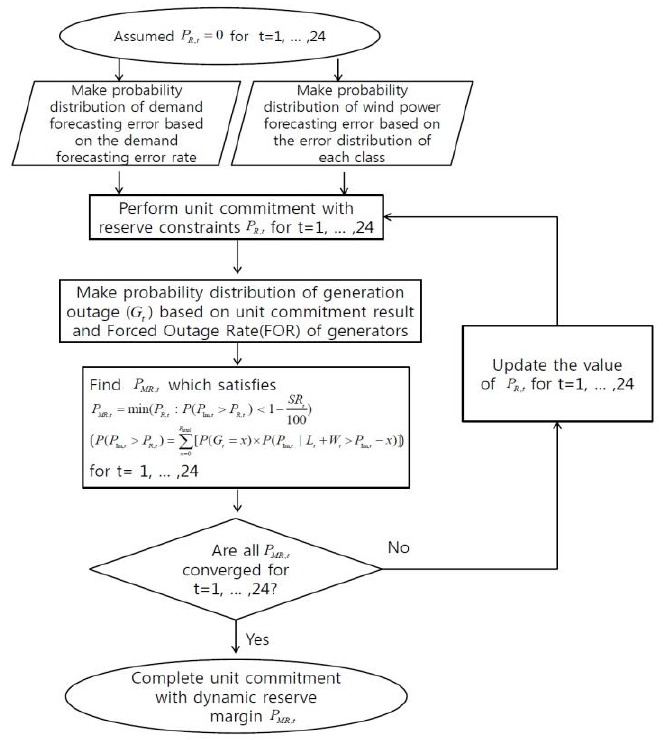
Figure 1. Solution method to determine the hourly spinning reserve margin.